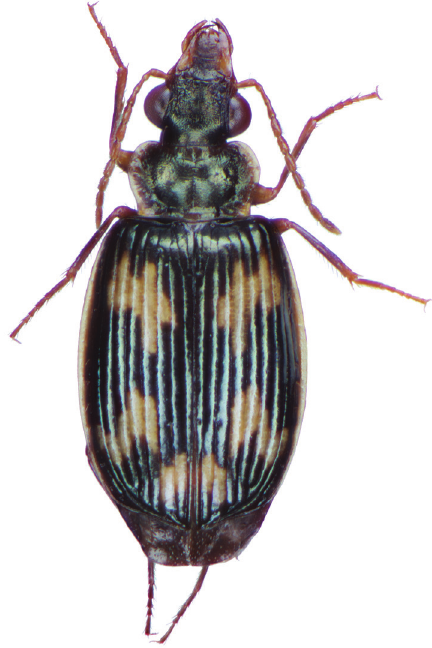
Figure 55. Dorsal habitus and color pattern of C. ( Coptoderina ) taiwana (Nakane). (OBL 6.02 mm).